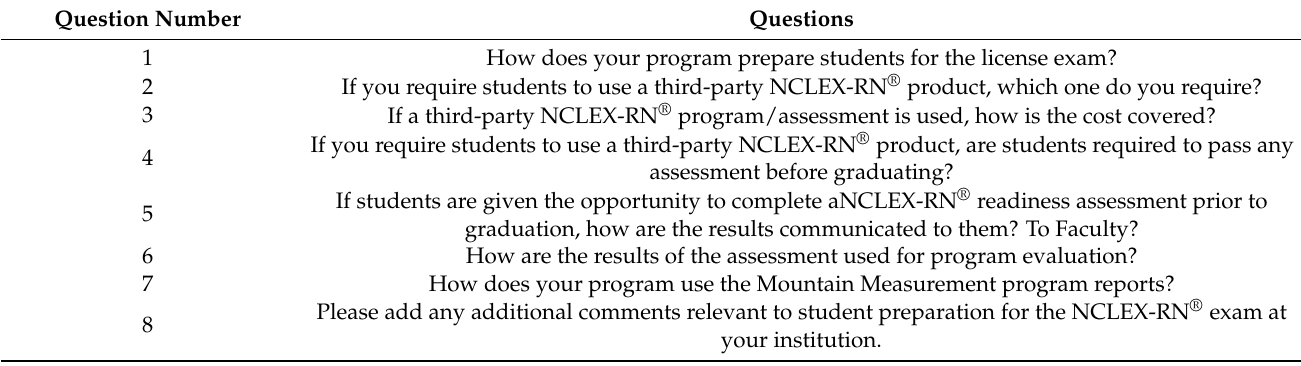
Table 1. Summarized specific survey